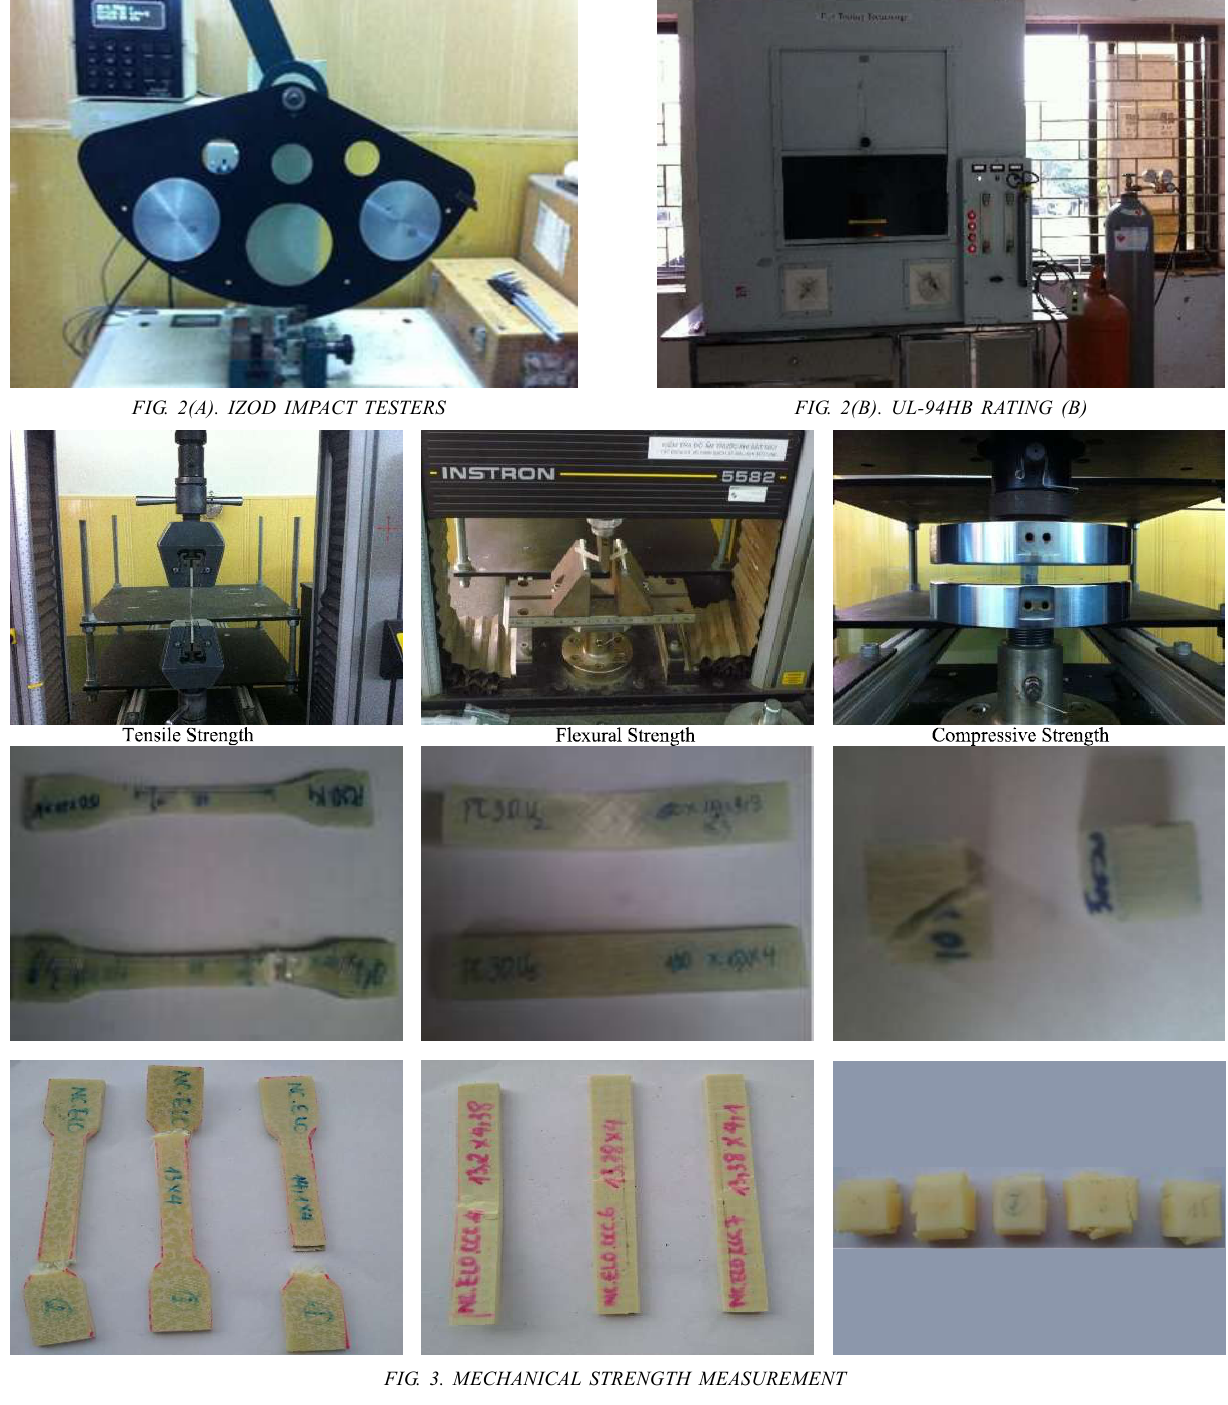
FIG. 3. MECHANICAL STRENGTH